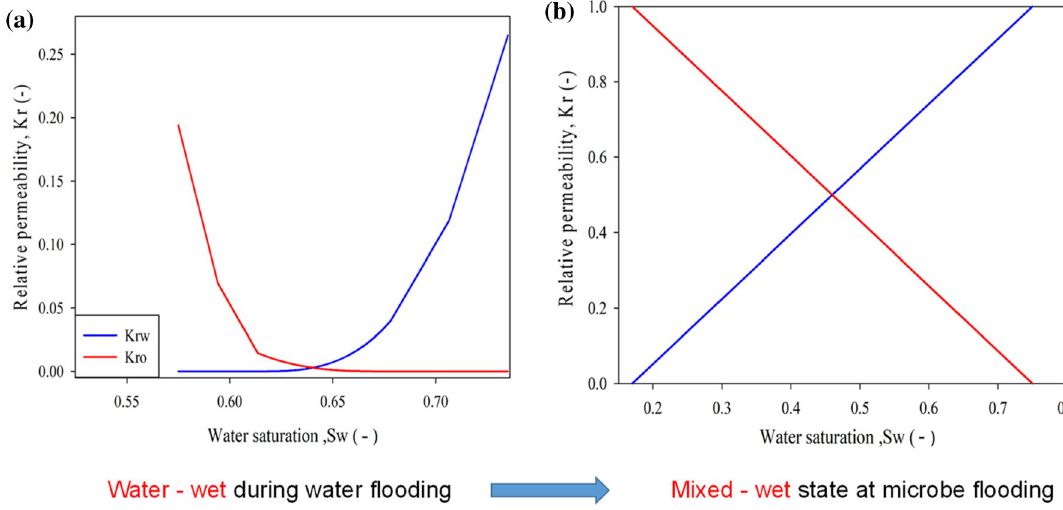
Fig. 1 Oil and water relative permeability curves a during waterflooding and b during microbe